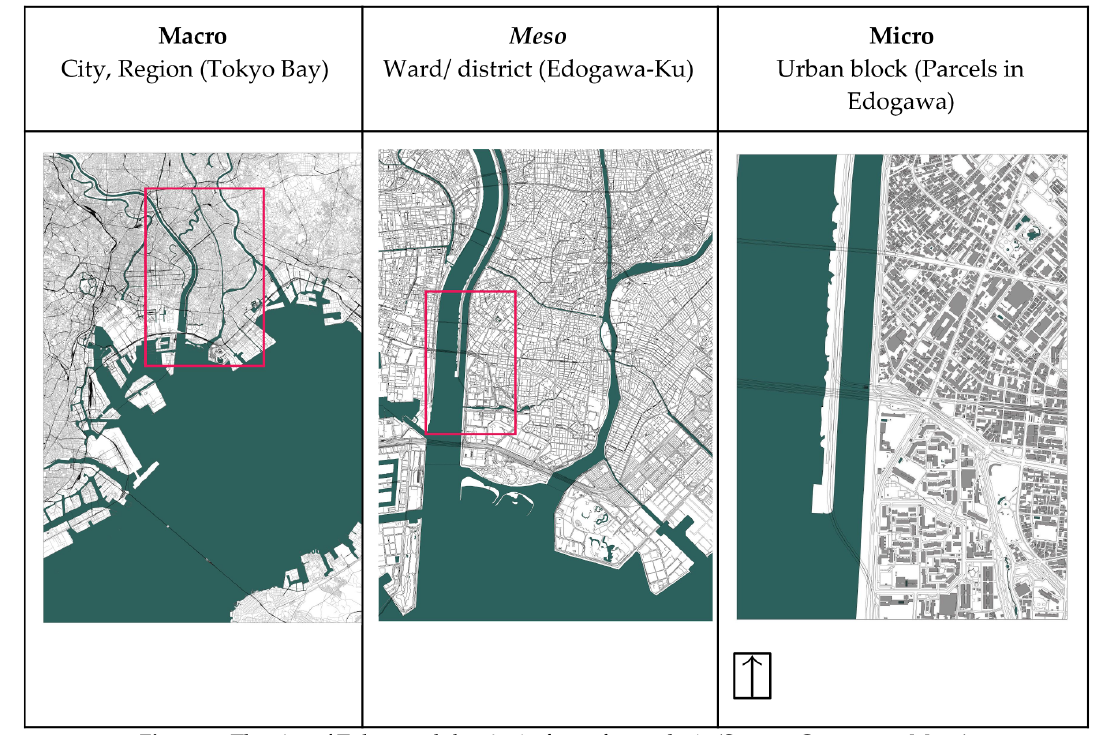
Figure 4. The city of Tokyo and the site in focus for analysis (Source: www.openstreetmap.org, maps not to